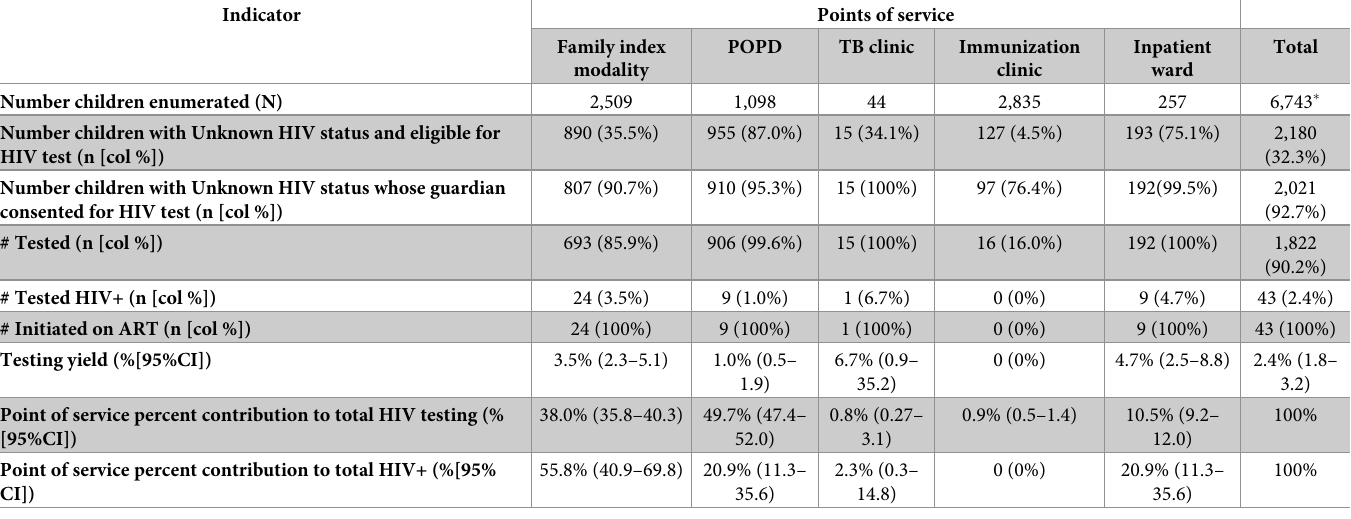
Table 2. HIV testing pediatric cascade by points of service across all PICF pilot sites. Indicator Points of